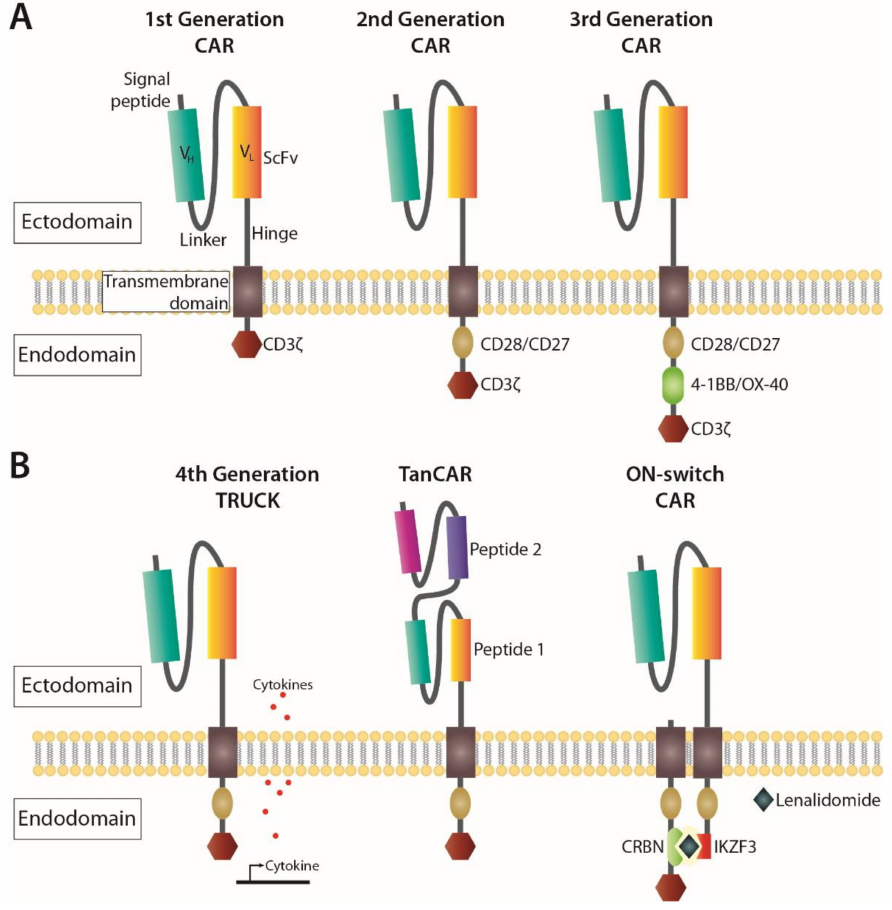
Figure 2. Schematic representation of chimeric antigen receptor (CAR) constructs. The ectodomain of a CAR contains a single-chain variable fragment (ScFv) region, which is derived from the antigen- binding fragment (Fab) of a monoclonal antibody containing a heavy-chain (V H ) linked to a light- chain (V L ), all linked to the transmembrane domain by a hinge region. The ScFv region contains an antigen recognition domain, which is specific for the desired tumour antigen to be targeted. ( A ) The first three generations of CAR constructs made alterations to the endodomain, which contains the intracellular signalling domain of the zeta ( ζ ) chain of the T cell receptor (TCR)/CD3 complex, and co-stimulatory signalling domains (CD27, CD28, 4-1BB or OX-40). ( B ) Later iterations of CARs based on the 2 nd generation CAR endodomain included induction of activating cytokines (4 th generation TRUCK), antigen recognition domains for two antigens (TanCAR) or required the addition of a small molecule, or Lenalidomide, for the dimerization (through zinc finger domains CRBN and IKZF3) and activation of the CAR (ON-switch